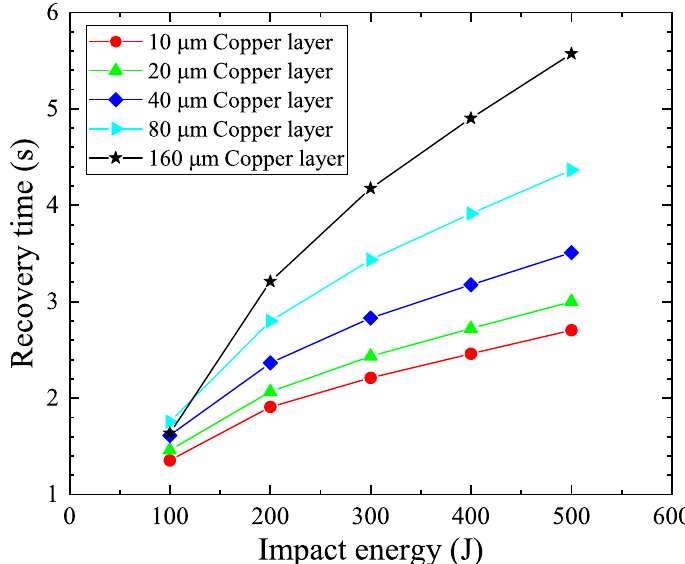
Figure 13. Curves of the recovery time as a function of impact energy when the width of the tape is constant at 4.8 mm and the unilateral thickness of the copper layer in the tape is 10 µ m, 20 µ m, 40 µ m, 80 µ m and 160 µ